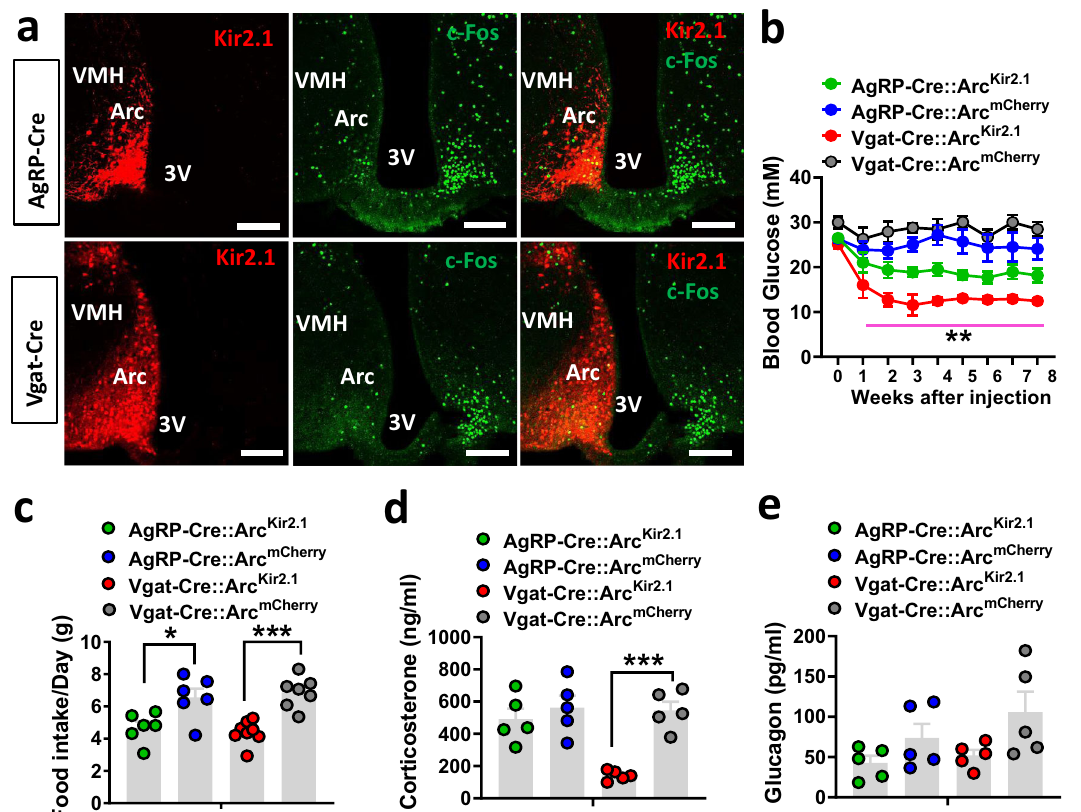
Fig. 4 Chronic inhibition of Arc neurons on T1D glucose. AgRP-Cre or Vgat-Cre mice (8 – 10 week-old males) were fi rst made STZ-T1D and then injected with AAV-DIO-Kir2.1-P2A-dTomato vectors or control AAV-Flex-mCherry to bilateral Arc. a Representative sections showing comparison in the expression of Kir2.1 (red) and c-Fos (green) in the Arc of AgRP-Cre mice (top) and Vgat-Cre (bottom), in which the Kir2.1 vector was delivered to one side of the Arc. Representative pictures from n = 2 mice. b – e Weekly glucose levels following injections of the viral vectors ( b , two-way ANOVA, n = 6 for AgRP-mCherry, AgRP-Kir2.1, or Vgat-mCherry, and n = 7 for Vgat-Kir2.1, F (3, 189) = 120.1, P = 0.0641, AgRP-mCherry vs AgRP-Kir2.1; ** P < 0.0001, Vgat- mCherry vs Vgat-Kir2.1), food intake during week 3 – 4 after viral delivery ( c , two-way ANOVA, n = 6 for both AgRP-mCherry and AgRP-Kir2.1, n = 9 for Vgat-mCherry, and n = 8 for Vgat-Kir2.1, F (3, 23) = 11.68, * P = 0.0149, AgRP-mCherry vs AgRP-Kir2.1; *** P = 0.0003, Vgat-mCherry vs Vgat-Kir2.1) and blood levels of corticosterone ( d , two-way ANOVA, n = 5/each, F (3, 16) = 12.16, P = 0.8091, AgRP-mCherry vs AgRP-Kir2.1; *** P = 0.0006, Vgat- mCherry vs Vgat-Kir2.1) and glucagon ( e , two-way ANOVA, n = 5/each, F (3,6) = 2.904, P = 0.06, Vgat-mCherry vs Vgat-Gi-DREADD at week 8 after viral injection. 3V the third ventricle, Arc arcuate nucleus. All data presented as mean ± SEM. Scale bar: 100 µ